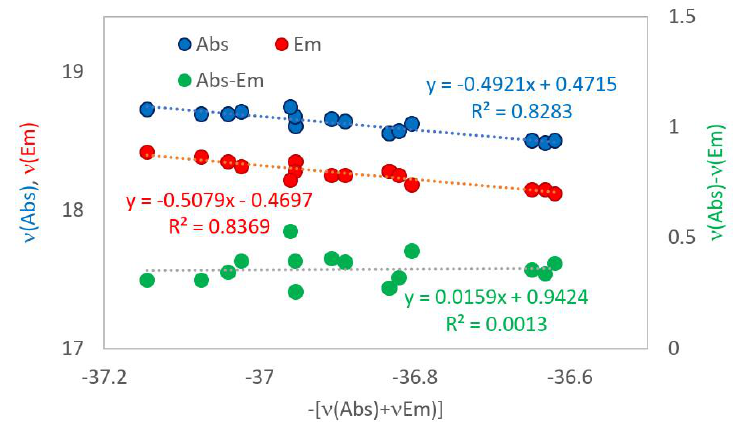
Figure 15. Relationships between the spectral properties of fluorophore 2016 Marfin(1975)–5 in a series of solvents according to Equations (1)–(3): A = 0.016, C = − 0.492, E = − 0.508. A pairwise comparison of Equations (2) and (2a), and (3) and (3a) yields slopes C and E ,